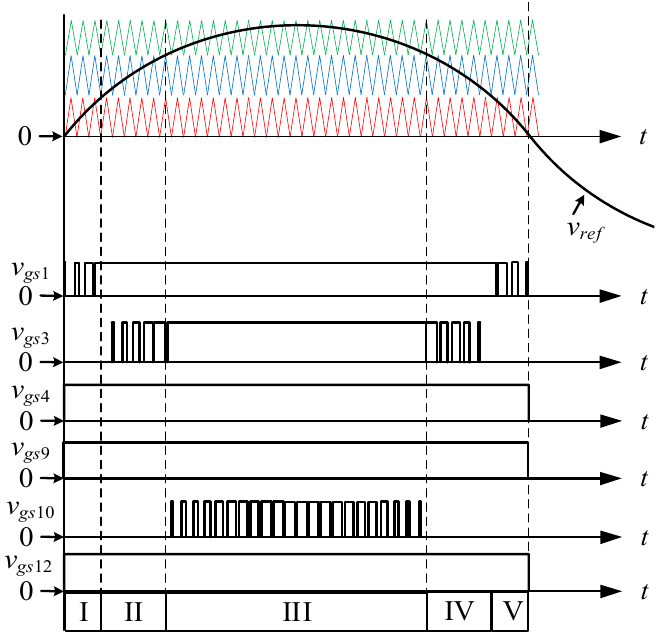
Figure 3. Waveforms of the gate driving signals for switches.